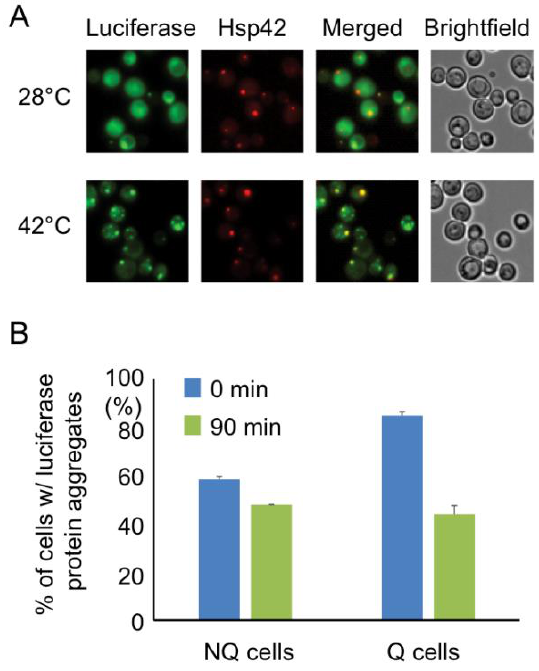
FIGURE 3: Hsp42-SPGs colocalize with heat shock-induced mis- folded protein. (A) Heat shock-induced misfolded protein colo- calizes to Hsp42-SPGs. Three-day stationary phase cells carrying Hsp42-BFP (Red) and an unstable mutant form of GFP-tagged luciferase (Green) were imaged before (28°C) and after (42°C) 30 min of mild heat shock at 42°C. The percentages of Hsp42-SPG- positive cells that colocalized with luciferase dots increased from 16 ± 2% to 70 ± 4% after heat shock. (B) Heat shock-induced protein aggregates are cleared more efficiently in Q cells. The luciferase-containing cells were monitored under a time-lapse microscope initiated before heat shock (see Materials and Meth- ods). The numbers of cells containing heat shock-induced protein aggregates were counted immediately after heat shock (0 min) or after recovering at 28°C for 90 min (90 min). 48% of luciferase aggregates ([85 – 44]/85 = 48%) were cleared in Q cells, but only 17% ([58 – 48]/58 = 17%) were cleared in NQ cells. Three sam- ples were analyzed in each condition and at least 100 cells were counted in each